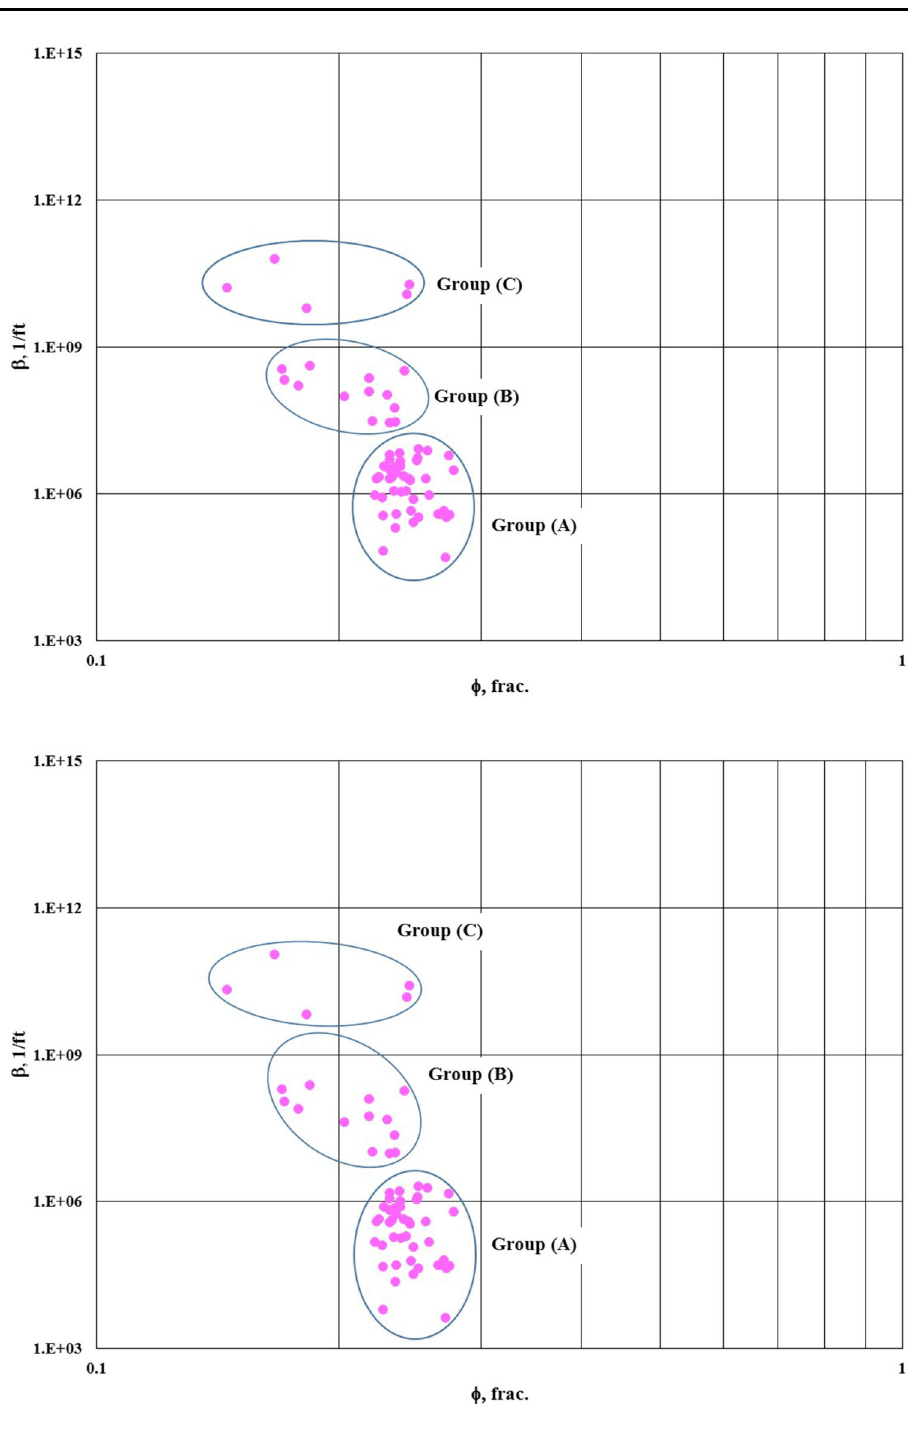
Fig. 2 Turbulence factor versus